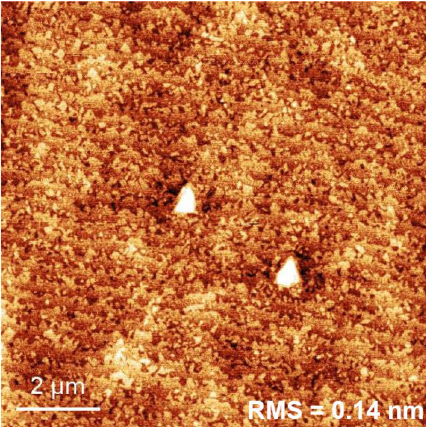
Figure 7. 10 × 10 µ m 2 AFM tapping amplitude image of GaAs buffer layer morphology, grown according to Ref. 16 and used in this work.